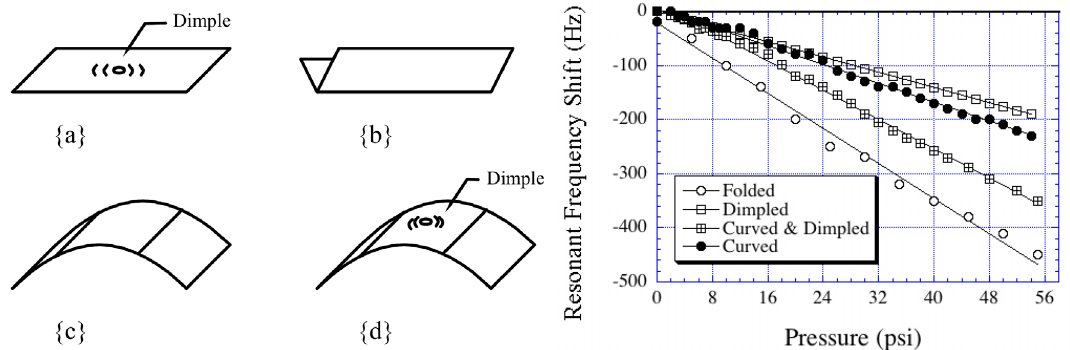
Figure 15. Different geometries used to stress the sensor: (a) a flat sensor with a dimple, (b) a folded sensor, (c) a curved sensor, and (d) a curved sensor with a dimple. Shift in sensor resonant frequency vs. pressure for the four sensor configurations. Reprinted with permission from [9].